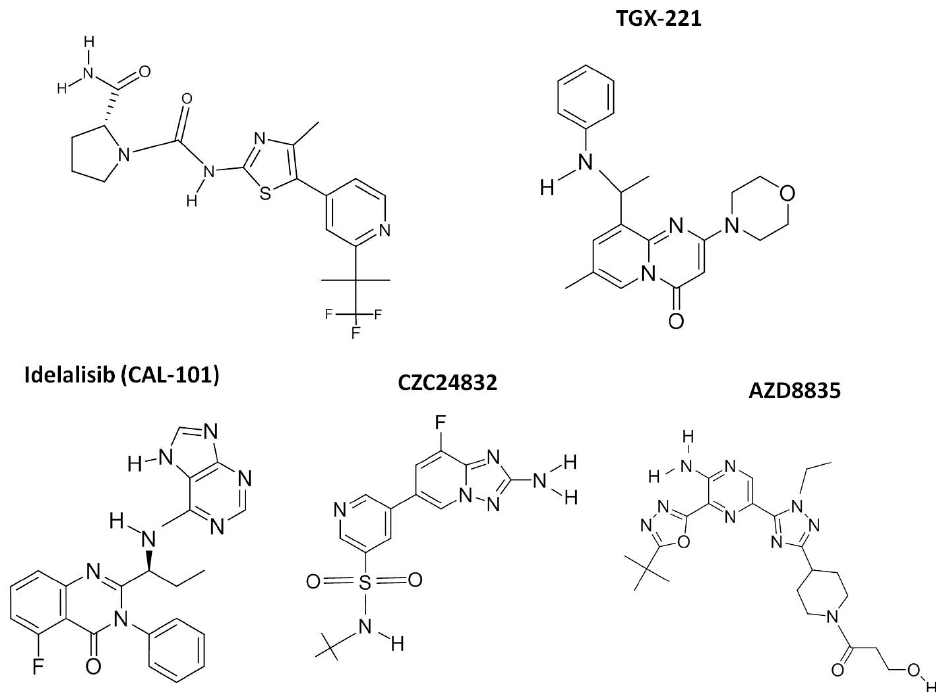
Figure 1. Chemical structure of PI3K class I inhibitors. The chemical structures of the five class I PI3K inhibitors used in this study are presented. Additional details regarding each compound, including the PubChem link are presented in Table 1.